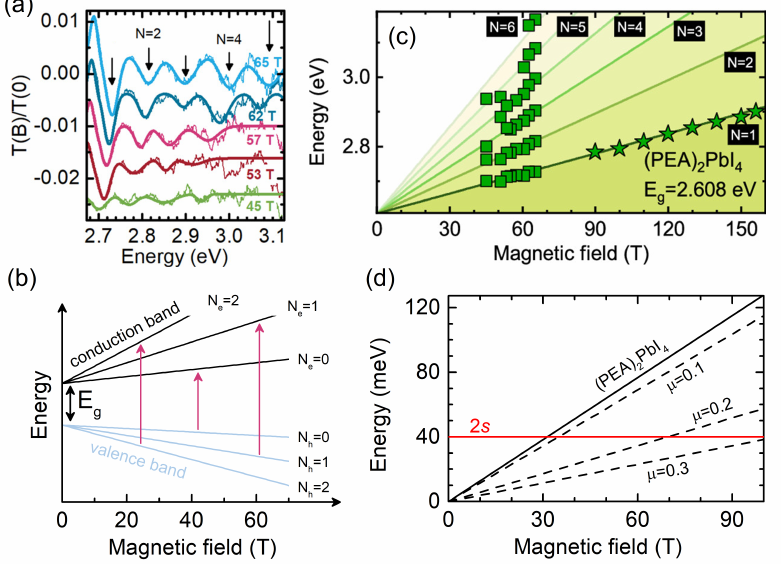
Figure 2. ( a ) Transmission ratio spectra T(B)/T(0) of (PEA) 2 PbI 4 at selected field strengths. ( b ) Schematic showing the evolution of Landau levels with increasing magnetic field. Arrows indicate the allowed interband optical transitions between Landau levels in the valence and conduction band, i.e., N h = N e . ( c ) Energy of the interband landau level transitions as a function of the magnetic field for (PEA) 2 PbI 4 . Solid lines represent fits with Equation (1). ( d ) Cyclotron energy dependence on the magnetic field strength for several reduced effective mass values and (PEA) 2 PbI 4 (solid black). The 2 s state binding energy of (PEA) 2 PbI 4 is indicated [44]. Panels ( a , c ) are reprinted (adapted) with permission from Dyksik et al. [14]. Copyright 2022 American Chemical